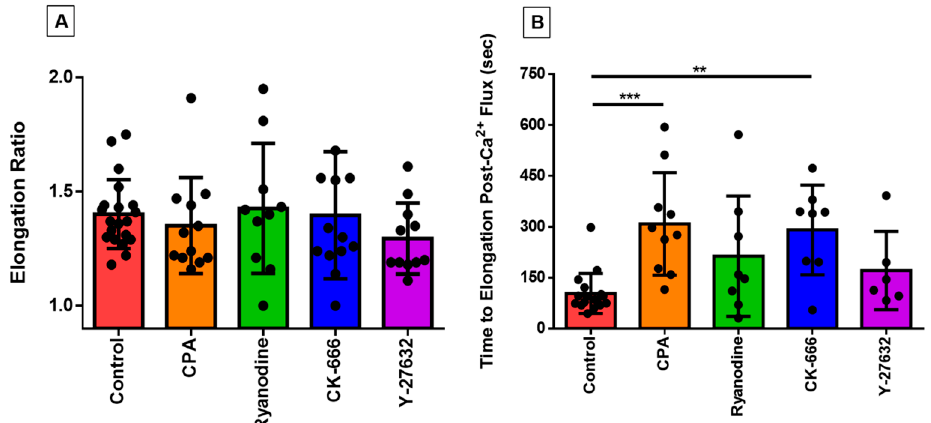
Figure 3. Analyzing the relationship between loss of circularity and the PICR in eosinophils. Each data point represents an individual eosinophil. ( A ) The peak elongation ratio for eosinophils under control conditions or in the presence of CPA, ryanodine, CK-666, or Y-27632, as indicated. ( B ) The time it took for the eosinophil to begin losing circularity after the calcium spike was measured across all treatment groups and compared against the untreated controls (*** p < 0.001; ** p < 0.01; p < 0.0001, Kruskal–Wallis test).